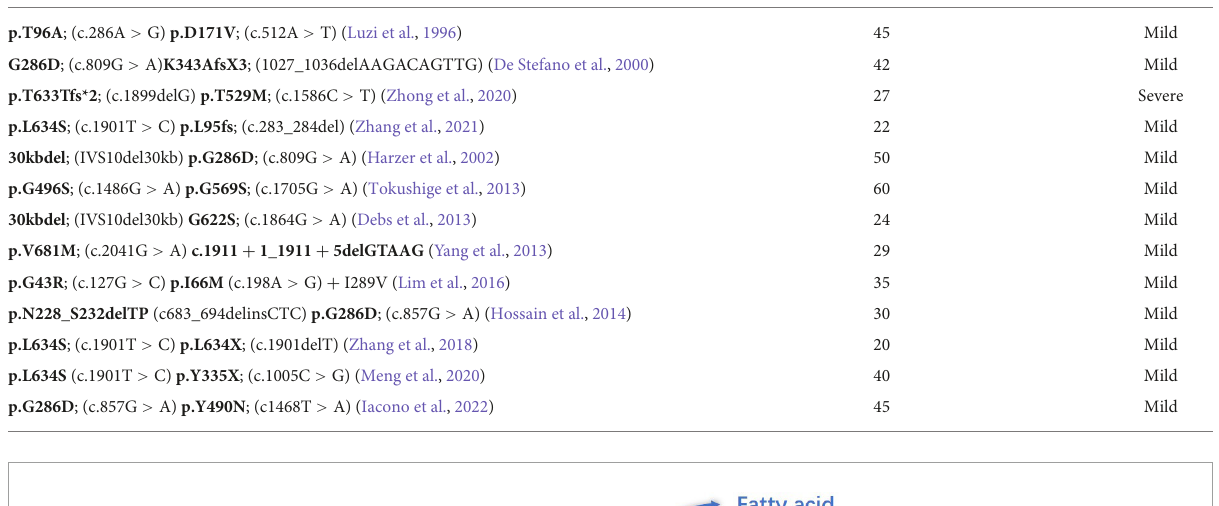
TABLE 1 The pathogenic genes associated with adult onset GLD. Gene genotype (Heterozygous mutations) Age of onset Comments